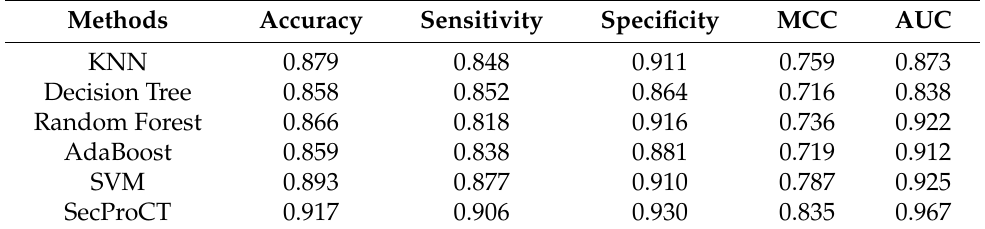
Table 2. Performance comparison with machine learning methods for predicting blood-secretory proteins.